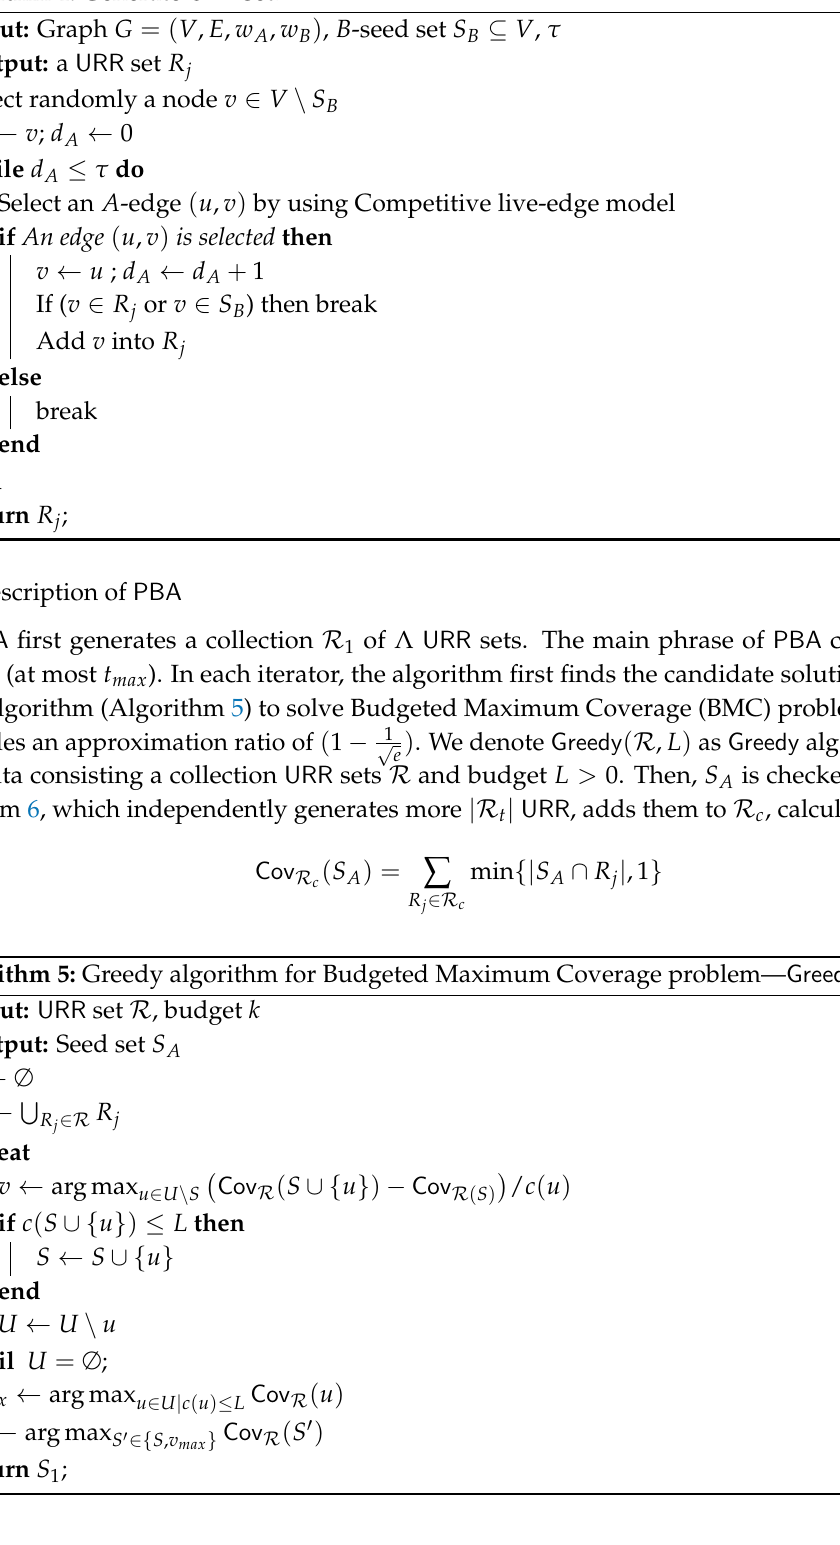
Algorithm 4: Generate URR set.